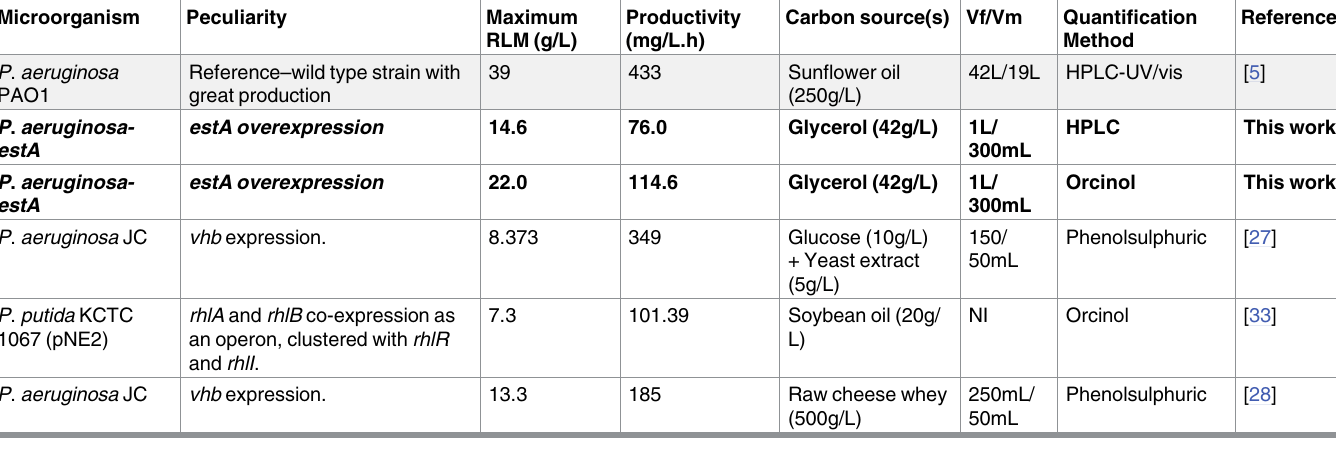
Table 4. Comparison between the transformed strains with the best production or productivity already reported in the literature and the results attained in this study, including one of best results achieved with a wild strain reported in the literature, for referencepurposes.